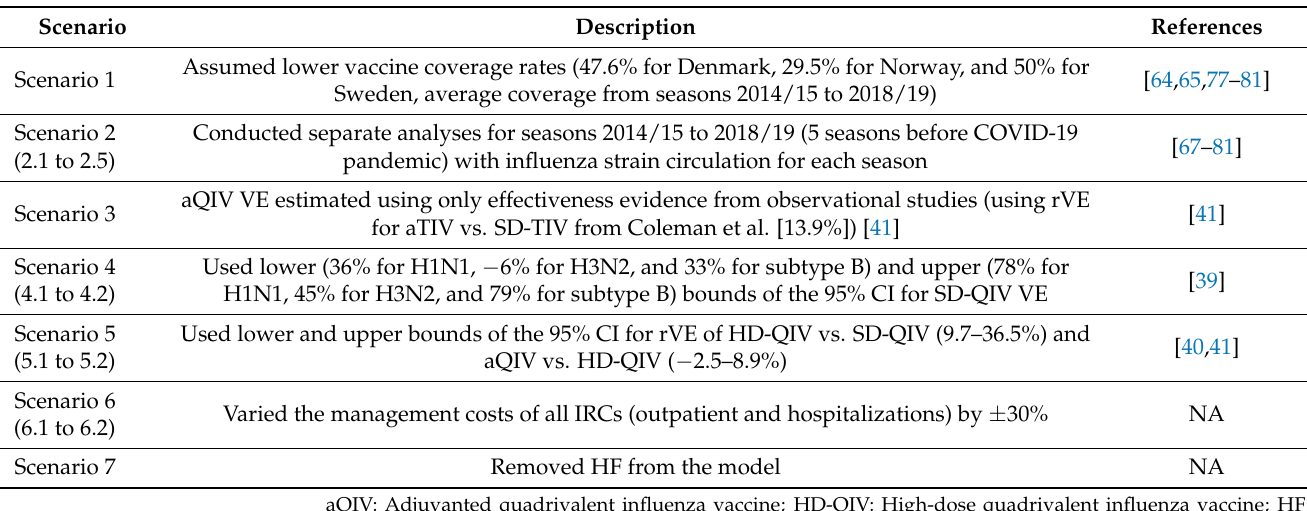
Table 3. Scenario